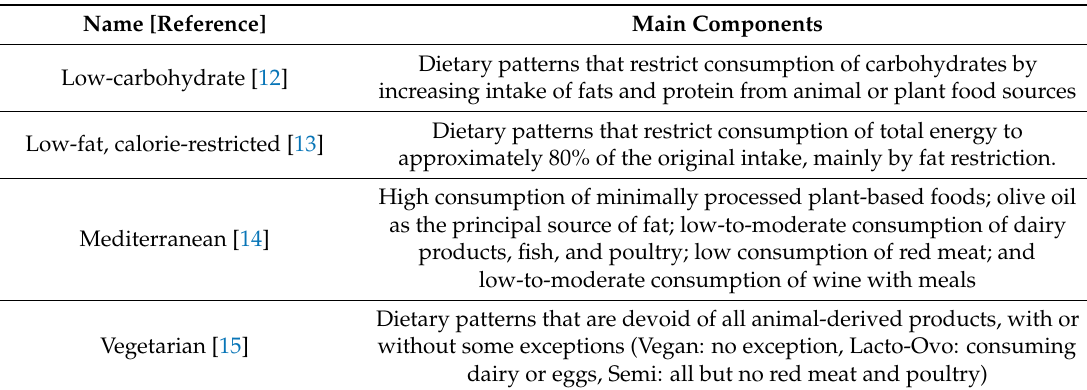
Table 1. Summary of diet options.